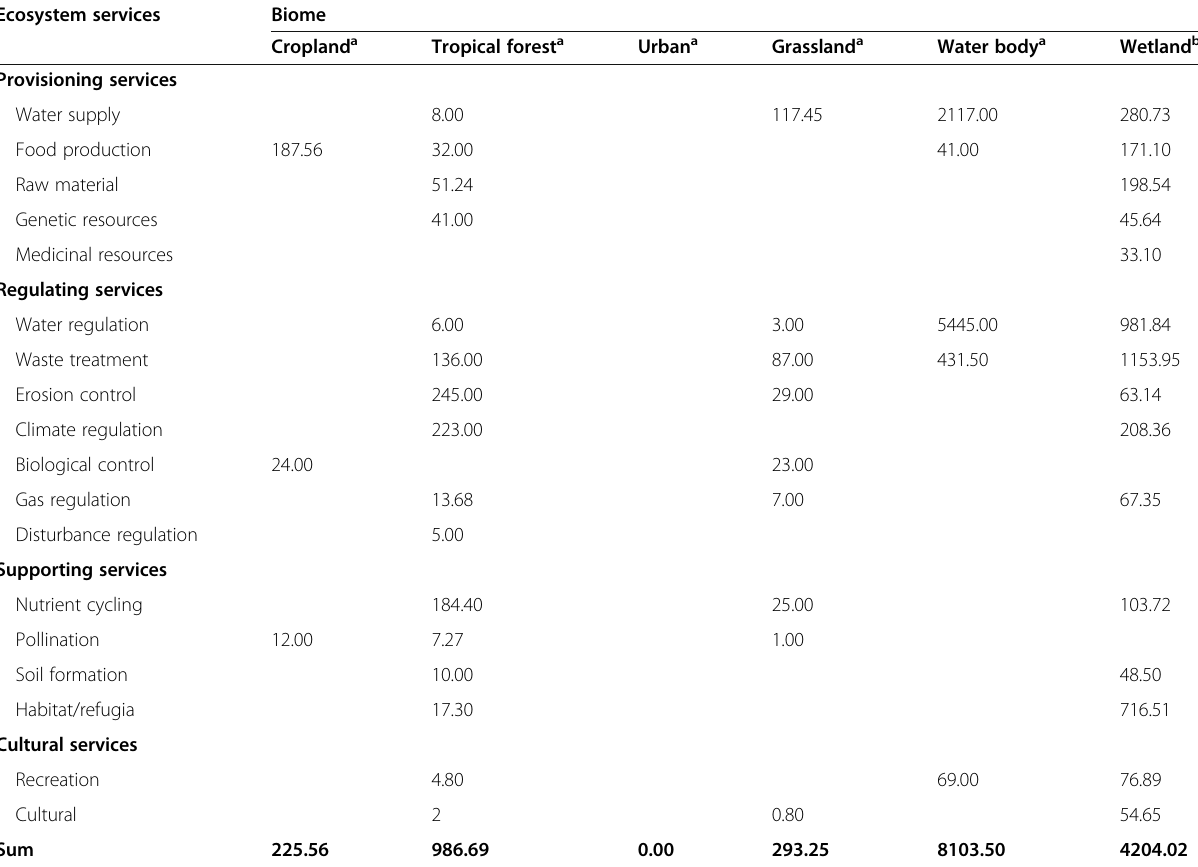
Table 4 The land use/land cover categories and their corresponding ecosystem sub-service values (USD/ha/year) for six representative